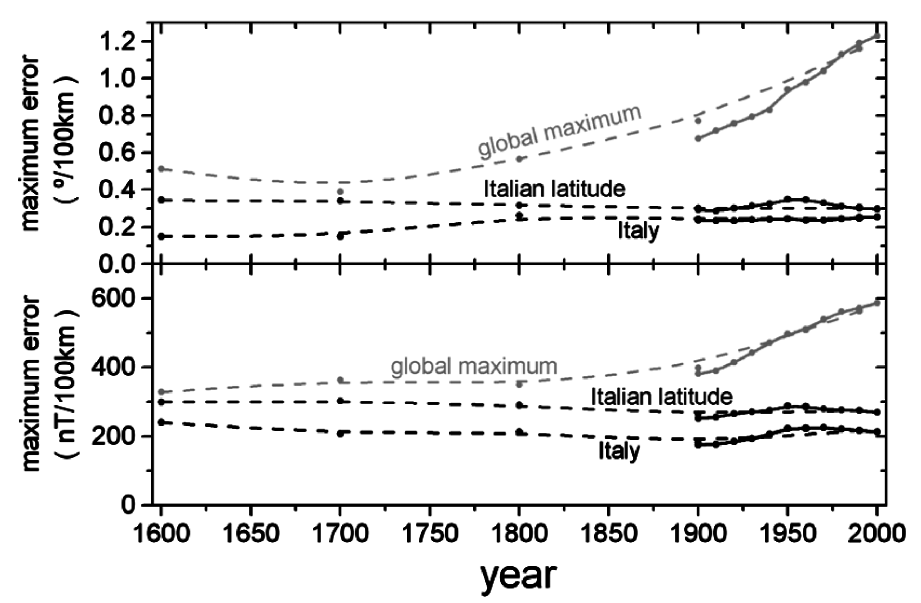
Fig. 4 . Evolution of the maximum values of (a) angular and (b) intensity relocation errors through time accord- ing to the GUFM1 and IGRF-9 models (dashed and continuous lines respectively). Bold (Italian maxima), dark grey (Italian latitude maxima), light grey (global